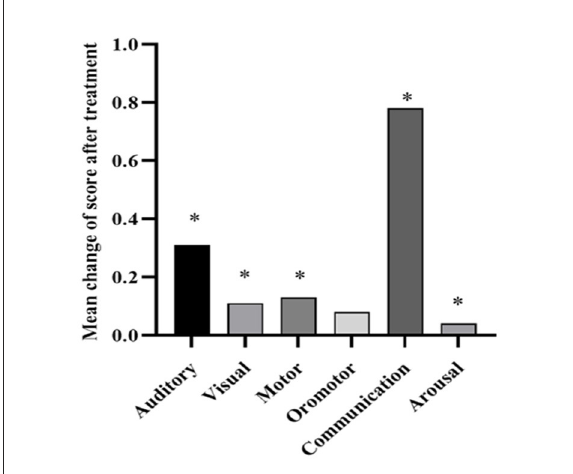
FIGURE7 CRS-R subscale change rate before and after treatment. Wilcoxon signed-rank test indicates significant differences (* p < 0.05).